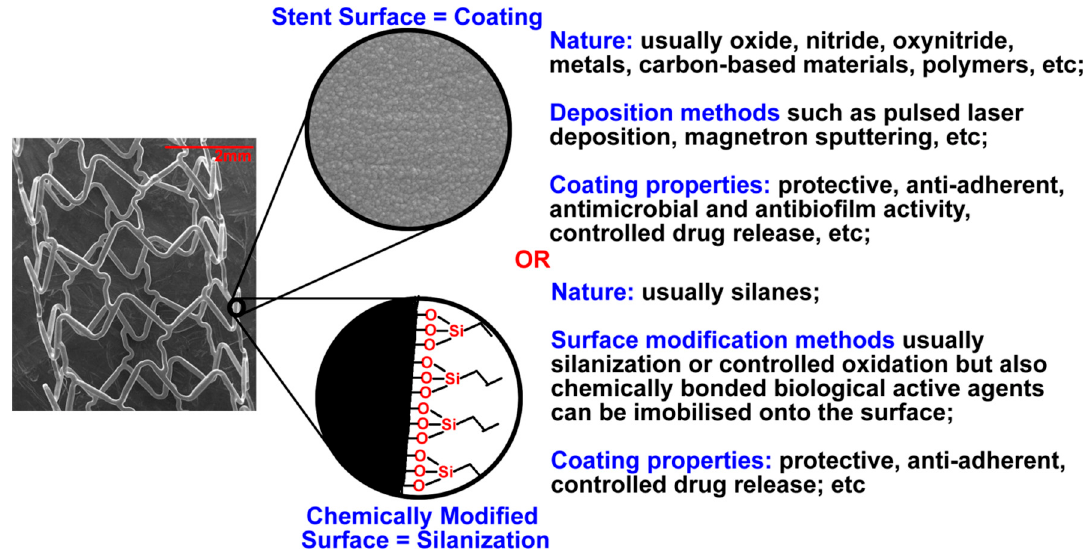
Figure 1. Stents surface modification techniques.